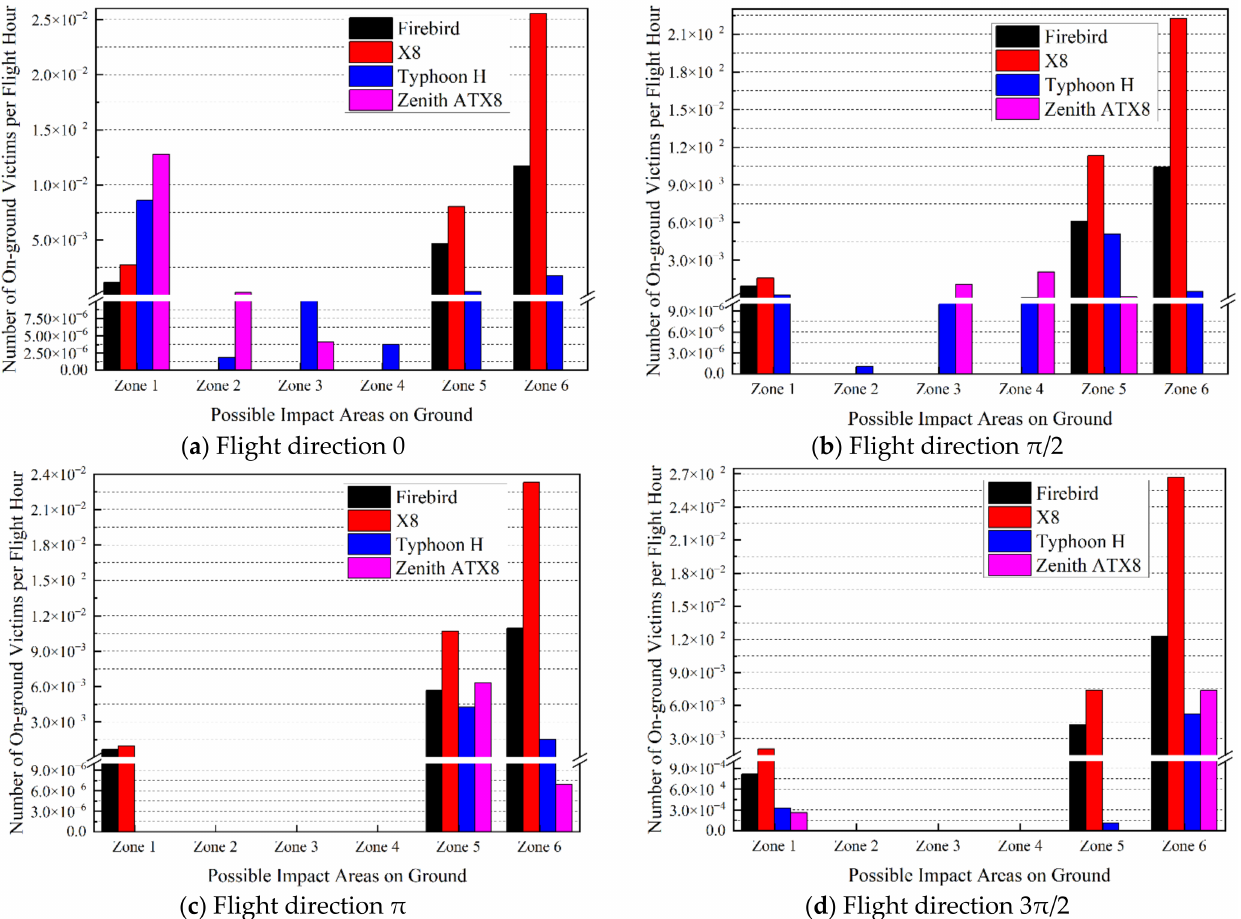
Figure 10. Ground fatalities with different flight